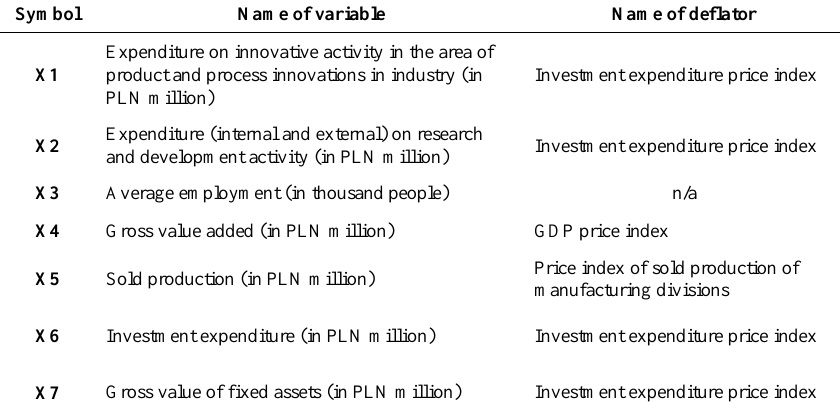
Table 5. List of diagnostic variables with assigned deflators